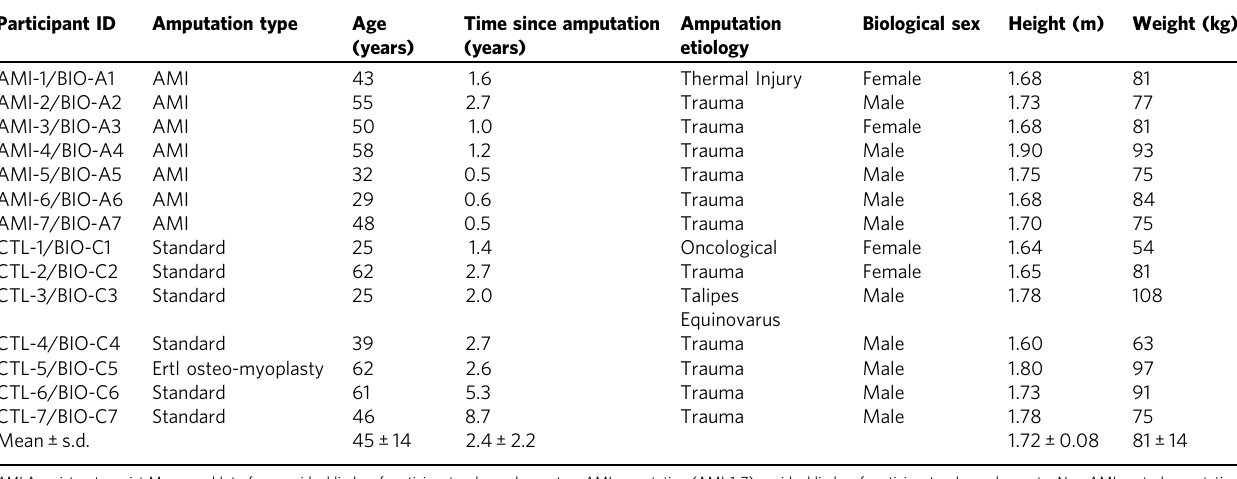
Table 1 Study population.